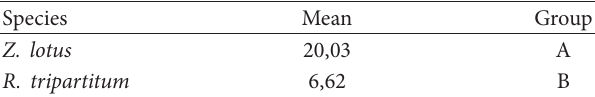
Table 2: Comparison of the speed of germination by Duncan test of two species of Ziziphus lotus and Rhus tripartitum as a result of water stress (species